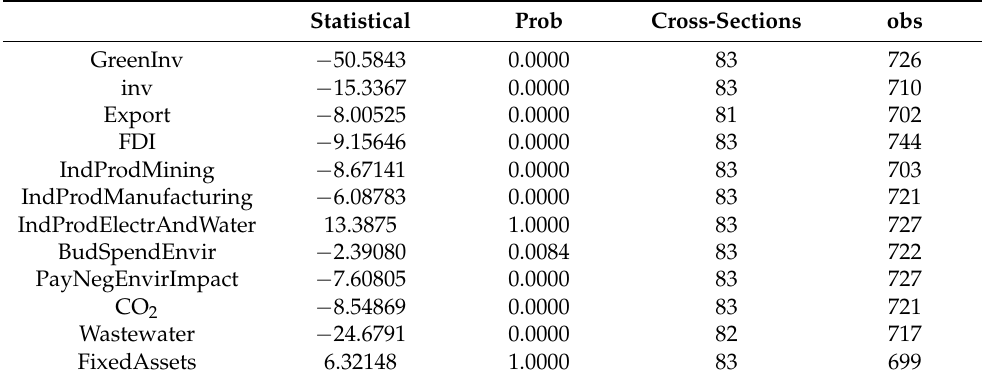
Table 2. Unit root test (Levin, Lin and Chu).